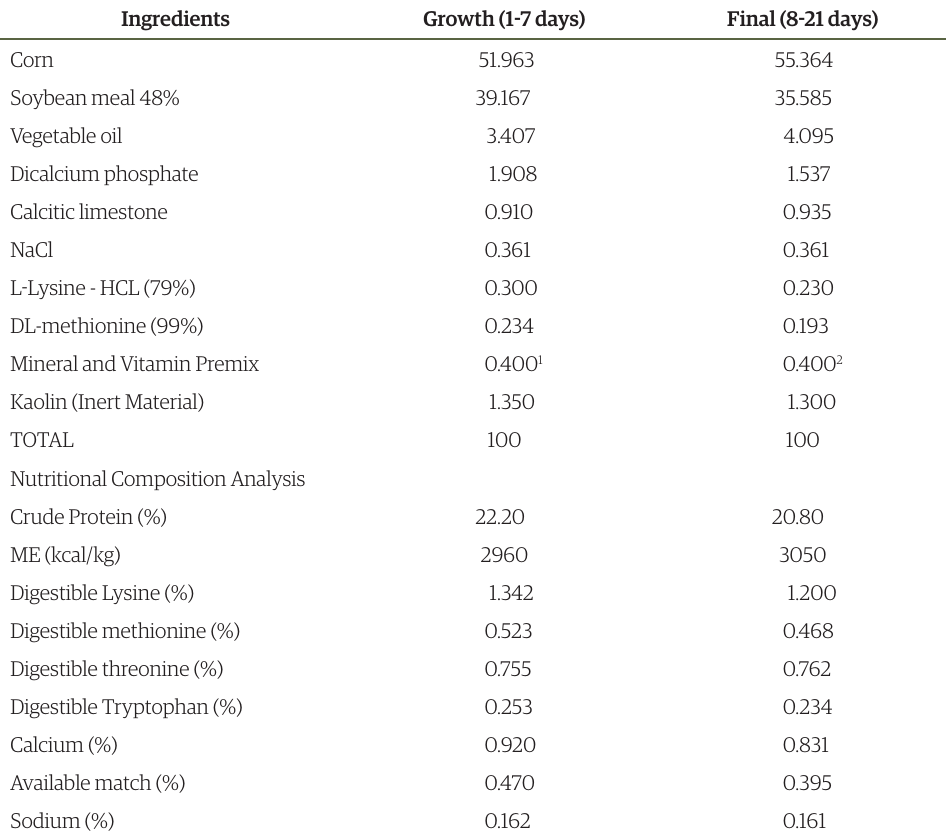
Table 1. Composition of experimental diets for broilers in the pre-starter, 1 to 7 days and initial, from 8 to 21 days old. Ingredients